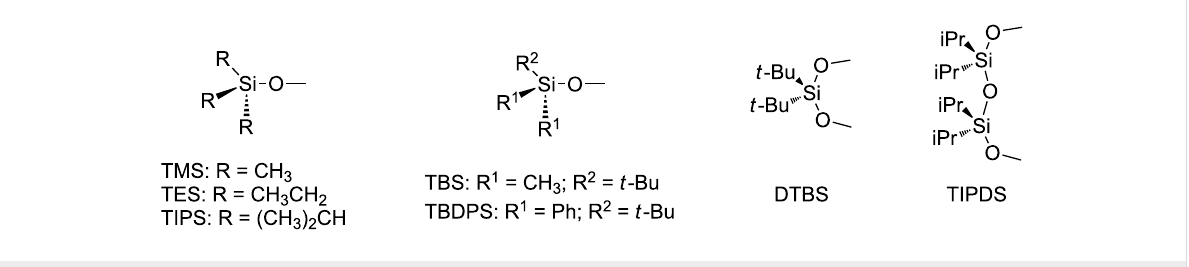
Figure 1: Silicon-protective groups typically used in carbohydrate chemistry.